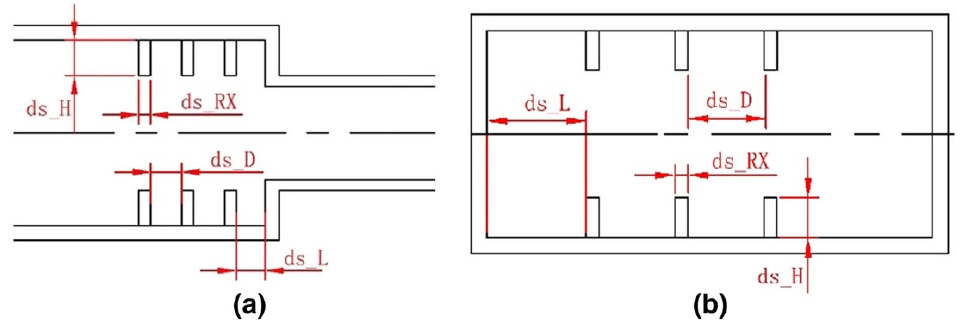
Figure 20. Arrangement of fins in a water heat exchanger: ( a ) transversely; ( b ) longitudinally. Reprint with permission [93]; Copyright 2021, Springer Nature.